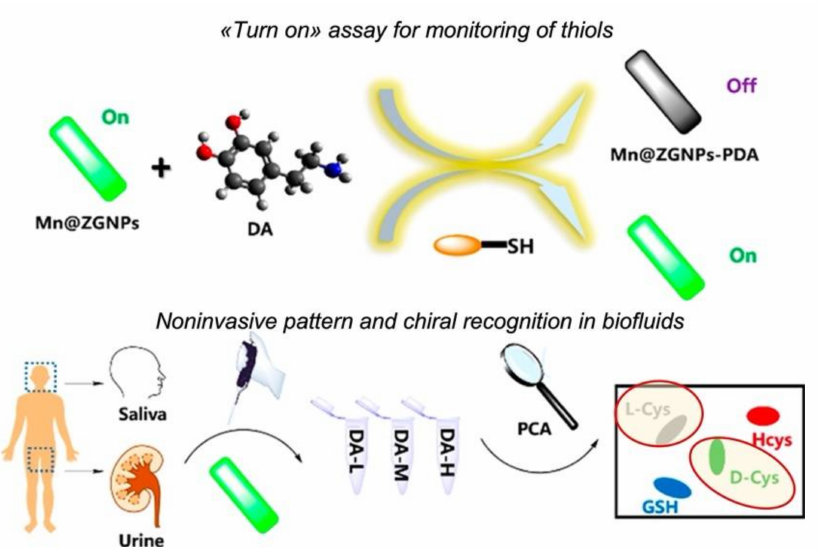
Figure 6. Illustration of the discrimination of thiols in biofluids by the “turn on” assay based on Mn(II)-doped zinc/germanium oxide nanoparticles and DA developed by Zhang and coworkers. Adapted from Ref. [37] with permission from the American Chemical Society, copyright